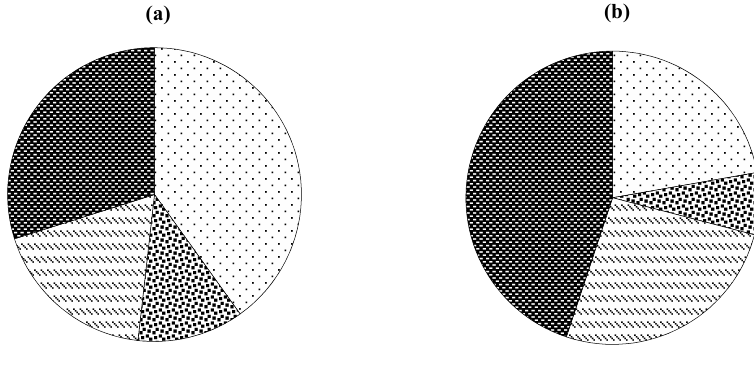
Figure 2. Proportion of areas of fish ponds, crab ponds, reed fields, and swamp wetlands: ( a ) before optimization; and ( b ) after optimization.